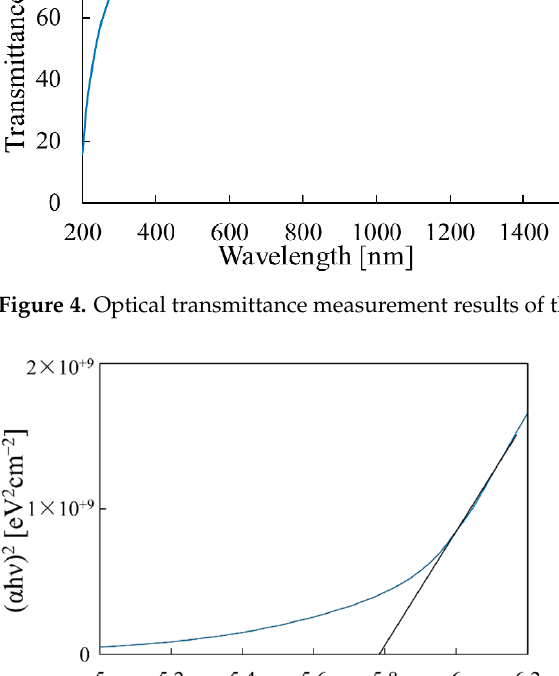
Figure 4. Optical transmittance measurement results of the Mg(OH) 2 film.